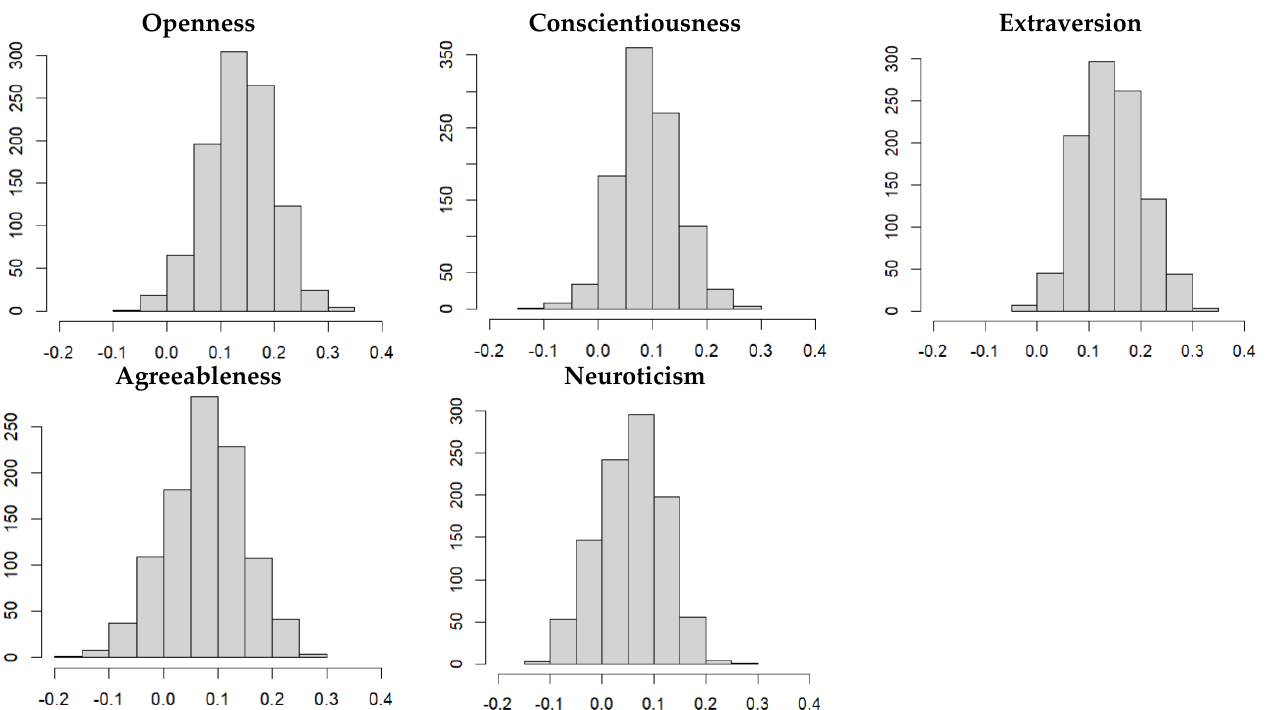
Figure 2. Distribution of model performances ( R measures) in the validation data sets. x-axis ranges from − 0.20 to 0.40.